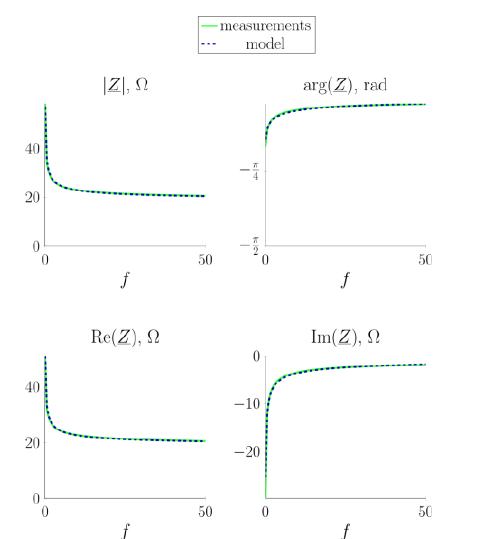
Fig. 3. Comparison of the frequency response of the supercapacitor with that of the applied